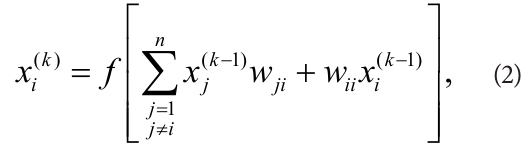
Table 2. The values according to the “strength of impact” Type of factors Type of impact Strength of